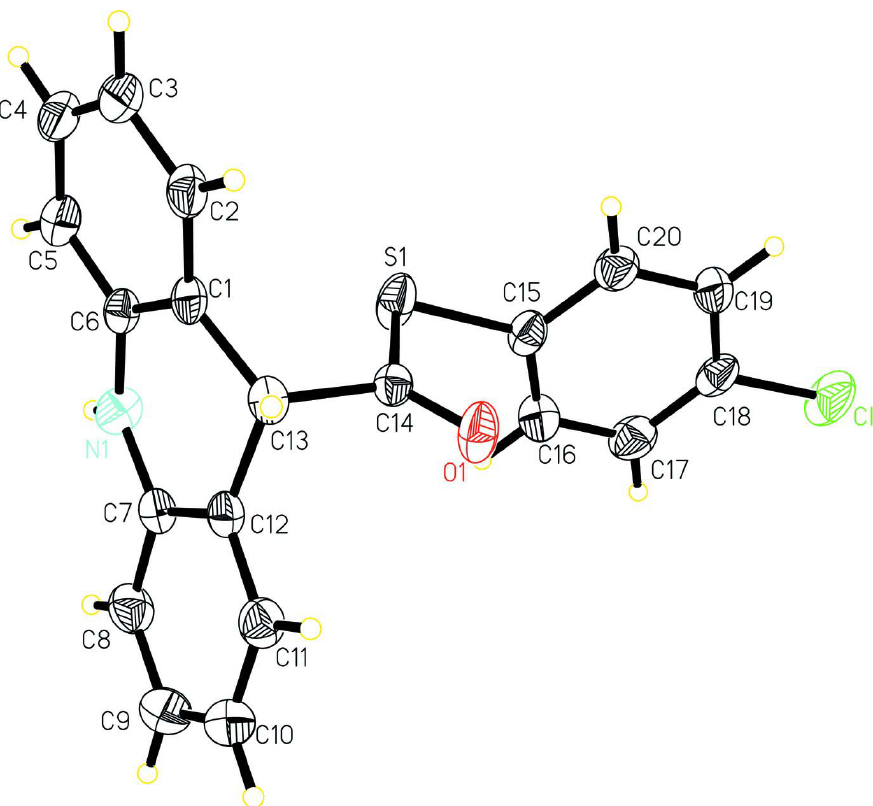
The molecular structure of the title compound with the atom-numbering scheme. Displacement ellipsoids are drawn at the 30% probability